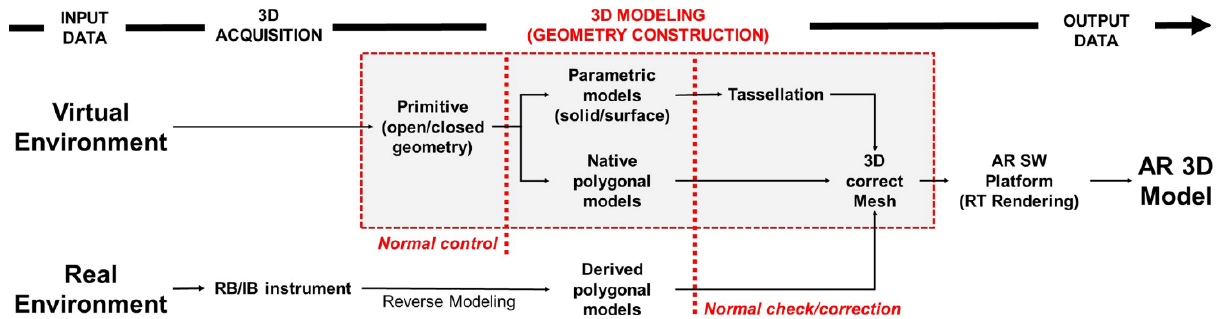
Figure 2: Pipeline from Virtual/Real Environment to AR 3D architectural model definition, with detail on 3D model construction. In fact, according to the principles of direct relationship between scale, proportions, proximity factors and point of view, there is mediated by tracked sensors which enrich environment